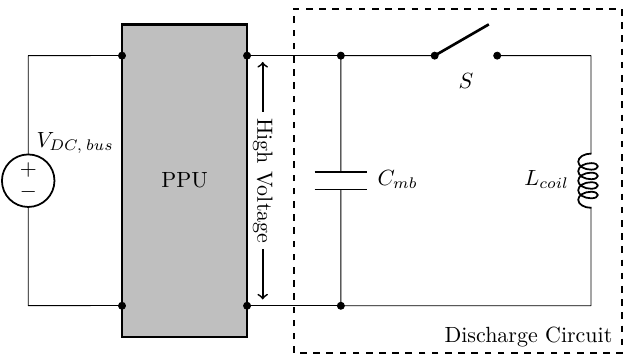
Figure 19. Diagram illustrating the location and role of the PPU in stepping-up the voltage for an IPPT capacitor bank.